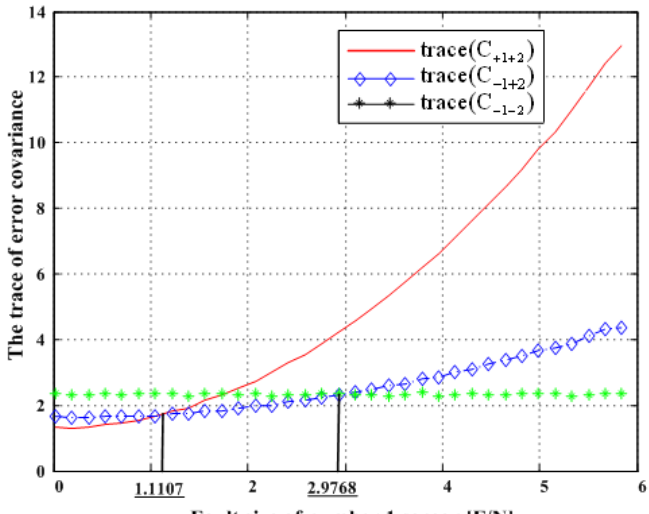
), trace(C )and trace(C ) with respect to fault magnitude in Figure +1+2 -1+2 -1-2